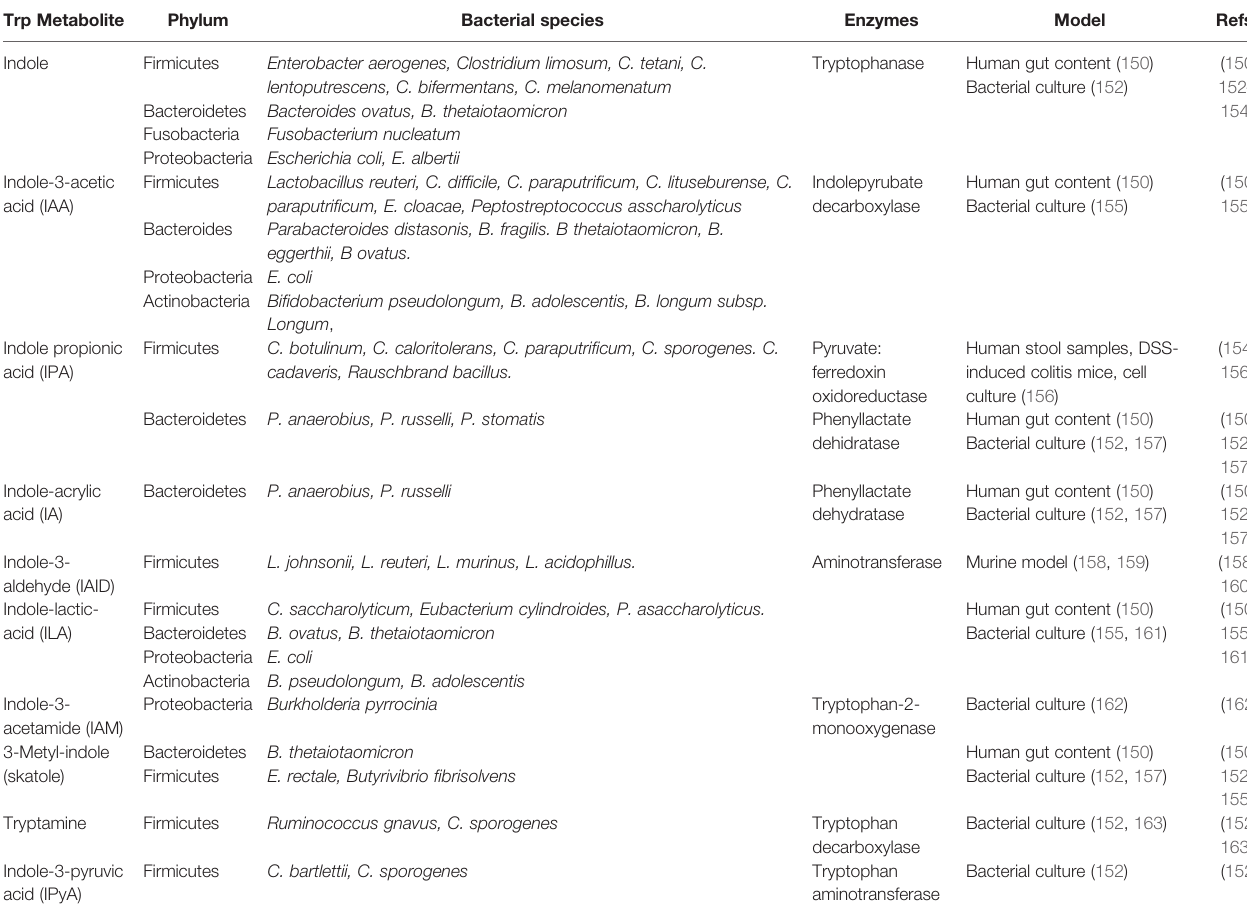
TABLE 1 | Gut bacterial species and enzymes involved in bacterial Tryptophan